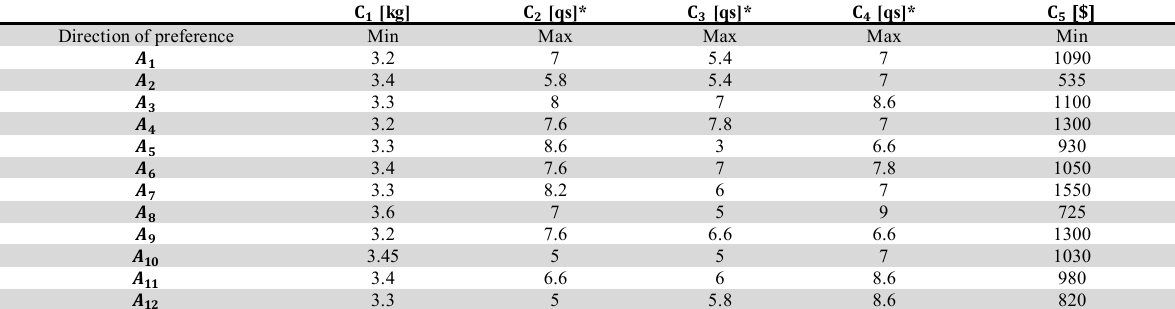
decision matrix